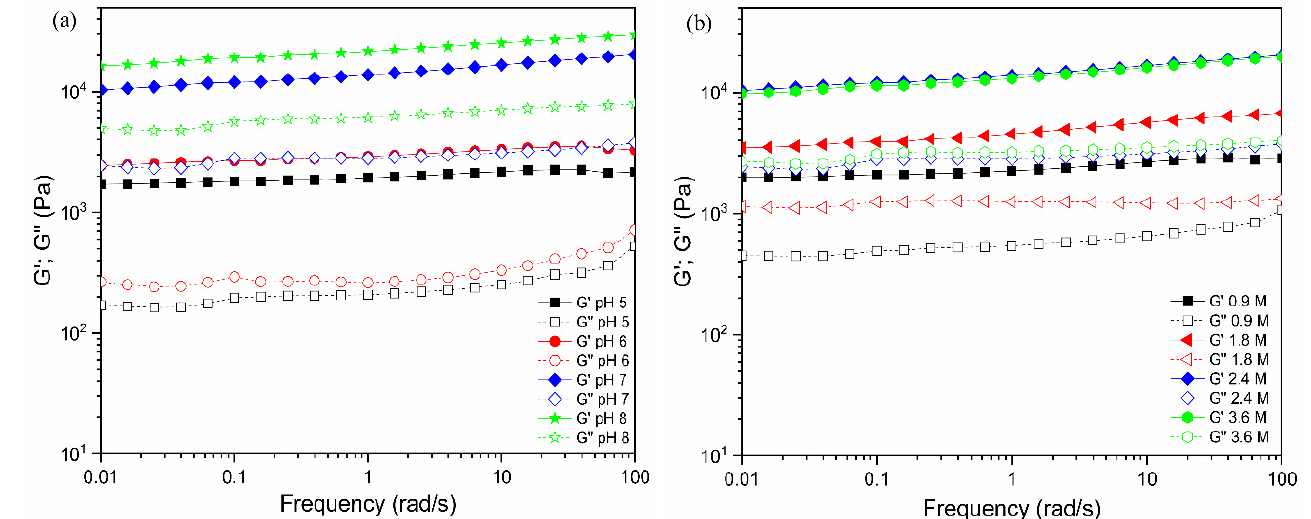
Figure 5. Frequency dependence of G ′ and G ″ moduli for pectin hydrogels prepared at different pHs ( a ) at 2.4 M Ca 2+ and calcium concentrations ( b ) at pH 7. The pectin content used for the gelation was 3%. The moduli values were measured at strain 1%, 25 °C.